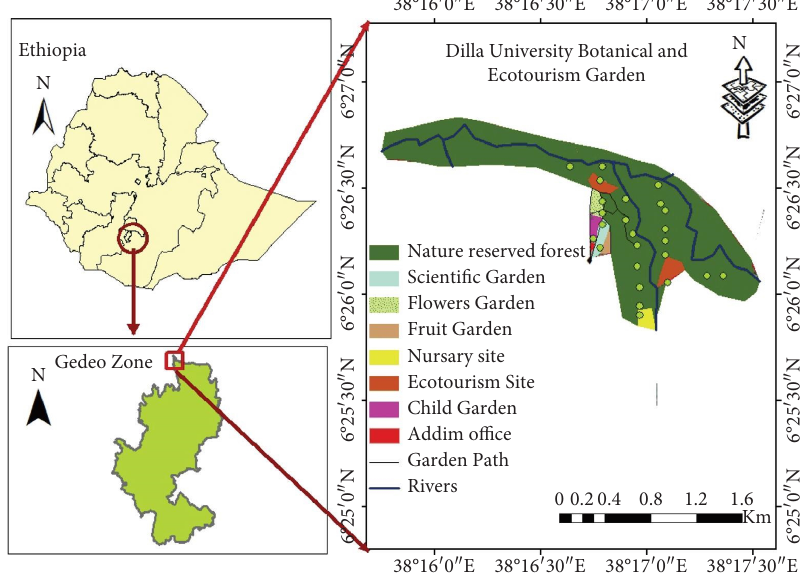
Figure 1: Map of the study DUBEG.